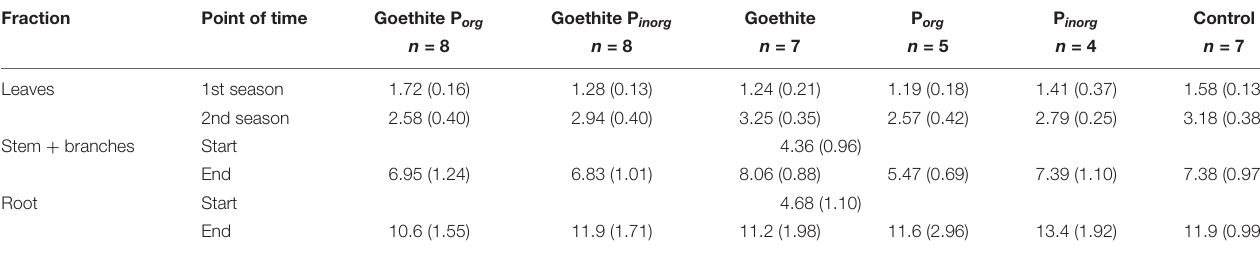
TABLE 3 | Biomass of beech fractions (g) at start ( n = 5) and end of the experiment. Fraction